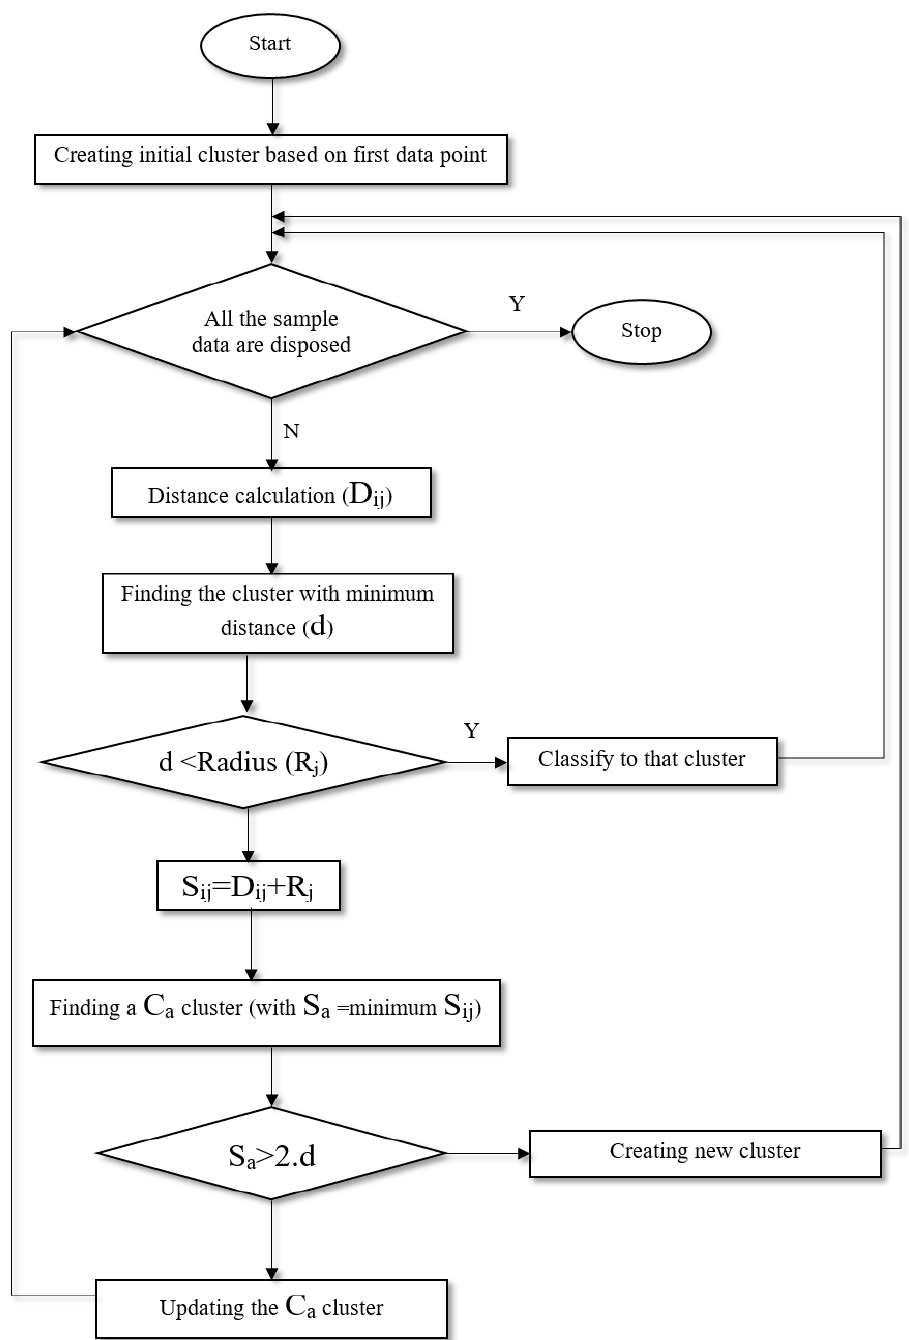
Figure 3. Flowchart of the ECM algorithm.